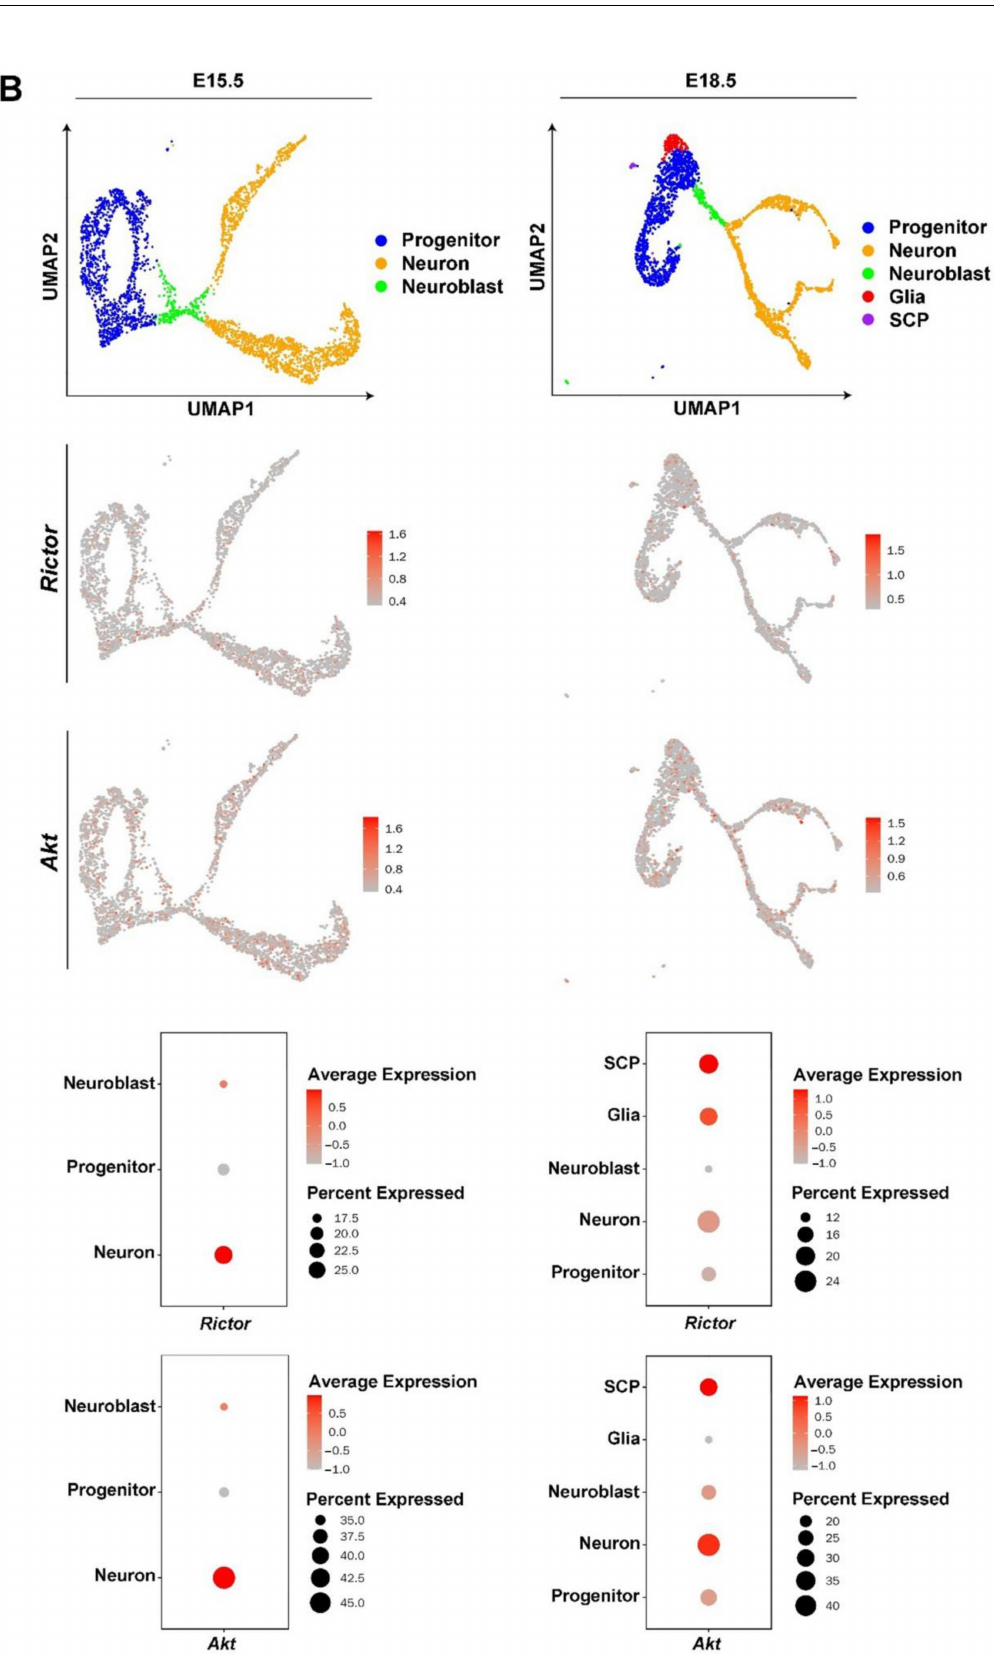
Figure 8. Interrogation of the cell type specificity of RICTOR and AKT in ENS